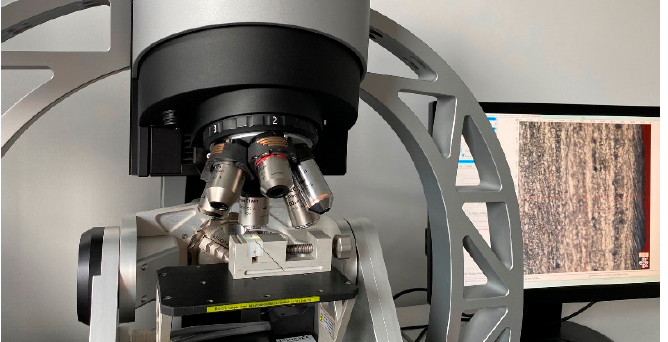
Figure 2. A focus variation microscope used for topography measurements with a wire in a holder.